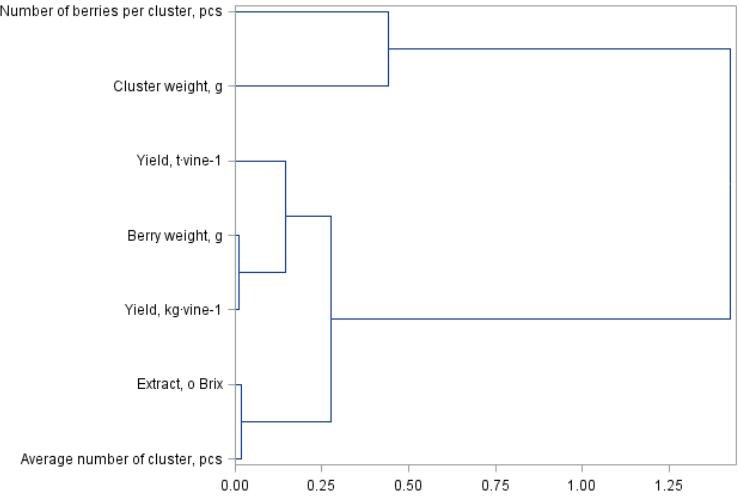
Figure 2. Branching-tree diagram for yield quantity and quality parameters of bushes grafted on Regent grapevine rootstocks.